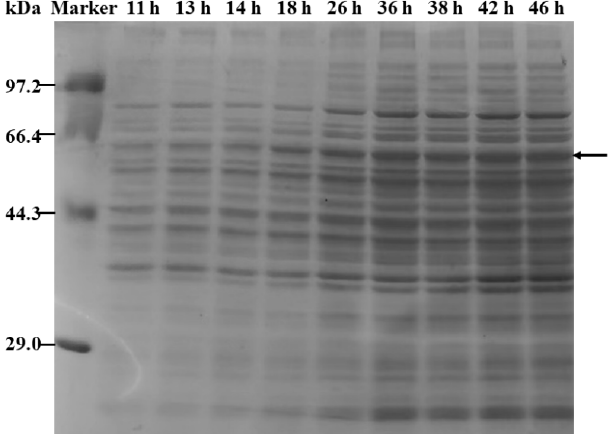
Figure 3. SDS ‐ PAGE analysis of SIase in the culture supernatant of the fed ‐ batch fermentation. Figure 3. SDS-PAGE analysis of SIase in the culture supernatant of the fed-batch